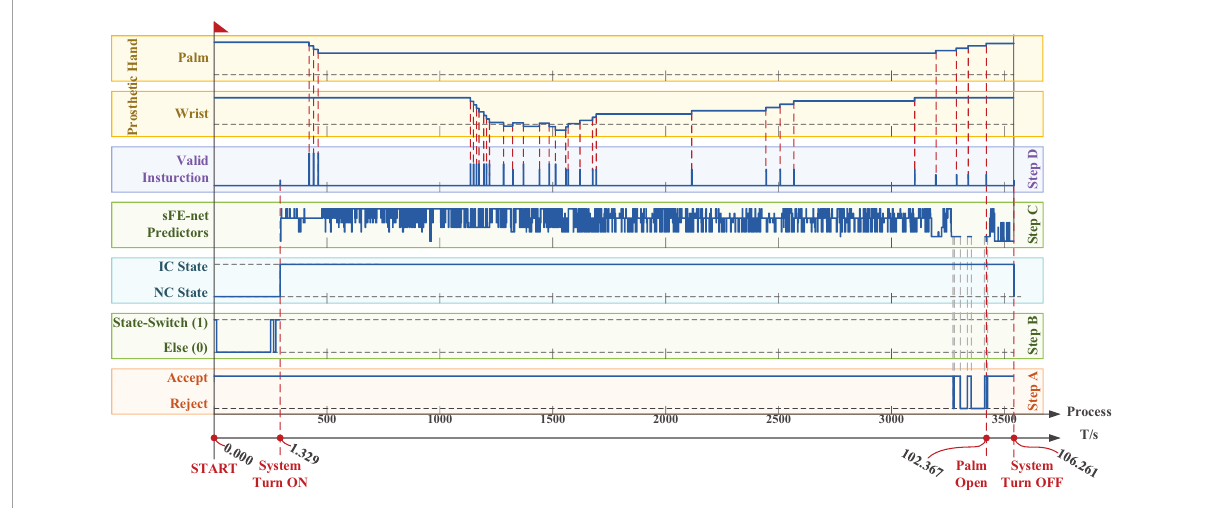
FIGURE22 The time log of a successful online manipulation in Task two . From bottom to top, the first axis is the timeline, and the second axis is a counter which represents the processing for n th 100 ms electroencephalograms (EEGs). The five boxes in the lower area illustrate the algorithm results along timeline step-by-step, and the two boxes in the upper area illustrate the 2-DoFs prosthetic hand movement. The timelines for all axes and all boxes remain aligned.